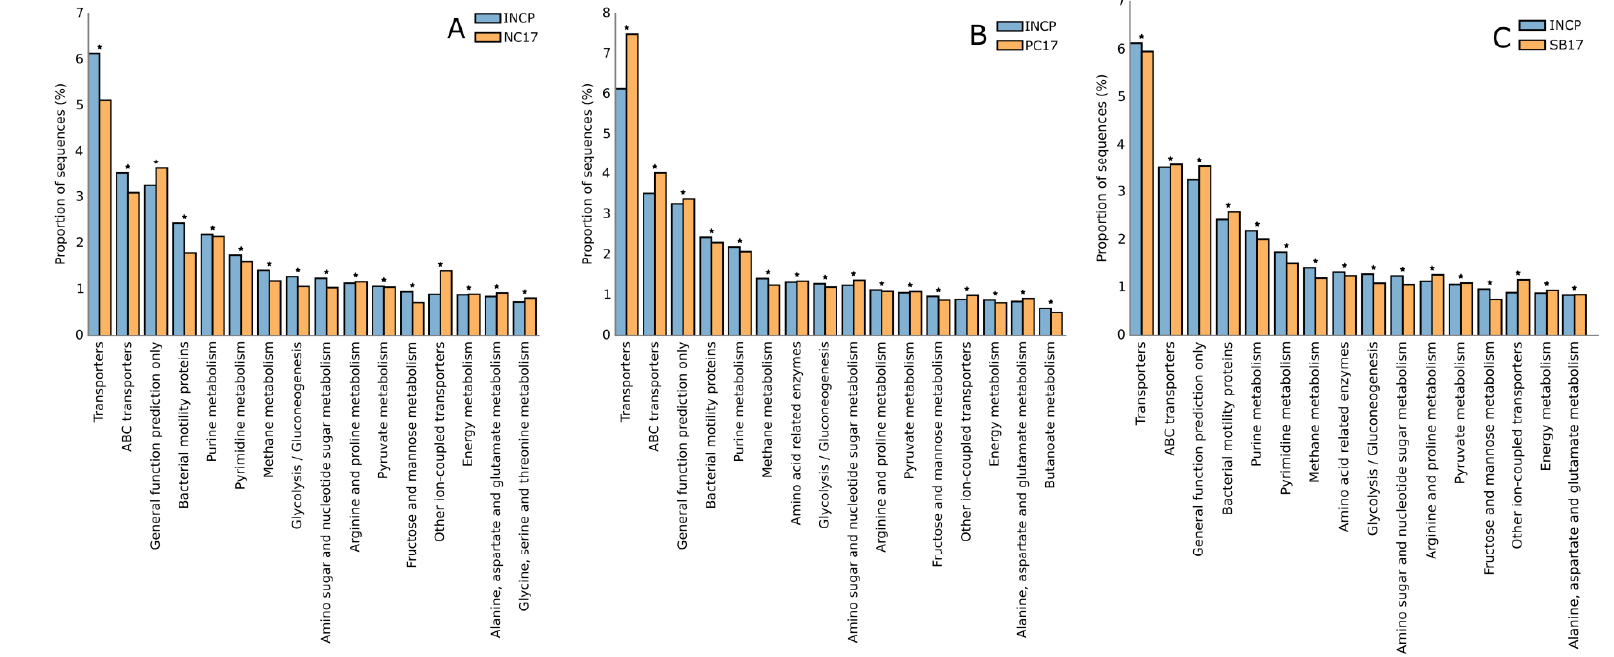
Figure 8. Prediction of metabolic pathways in the bacteria. This figure shows the predicted metabolic pathway between: ( A ) The inoculum (INCP) and negative control at the 17th day (NC17); ( B ) inoculum (INCP) and positive control at the 17th day (PC17); ( C ) inoculum (INCP) and substrate at the 17th day (SB17). The x-axis shows the predicted metabolic pathways; the y-axis indicates the proportion of sequences as a percentage (%). The star (*) represents the statistical difference between samples with at least p < 0.05, and q < 0.05 using Benjamini-Hochberg correction.